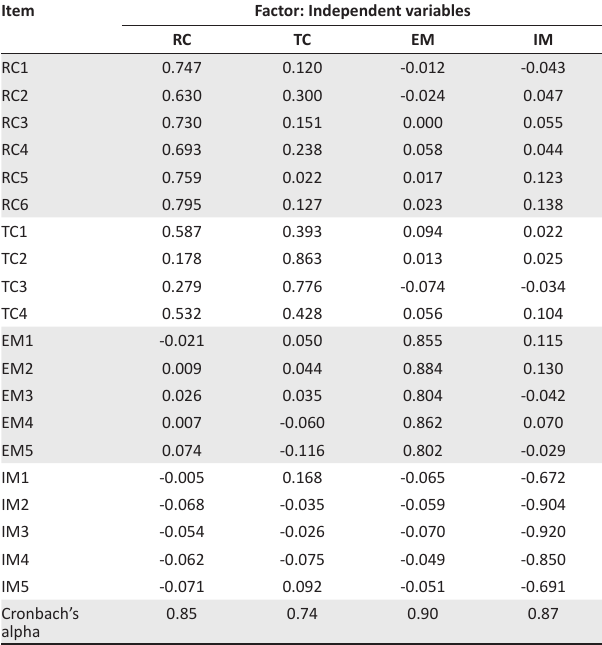
TABLE 3: Factor structure of the independent and moderating variables.